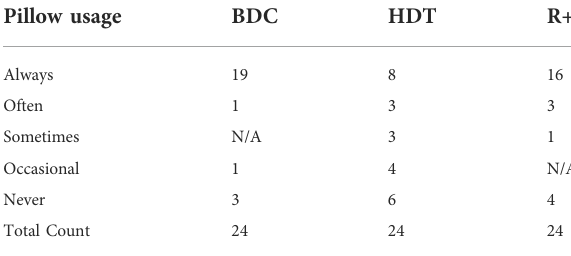
TABLE 2 Number of participants and pillow usage frequency for each of the study phases. Only the custom-made side pillow was allowed during